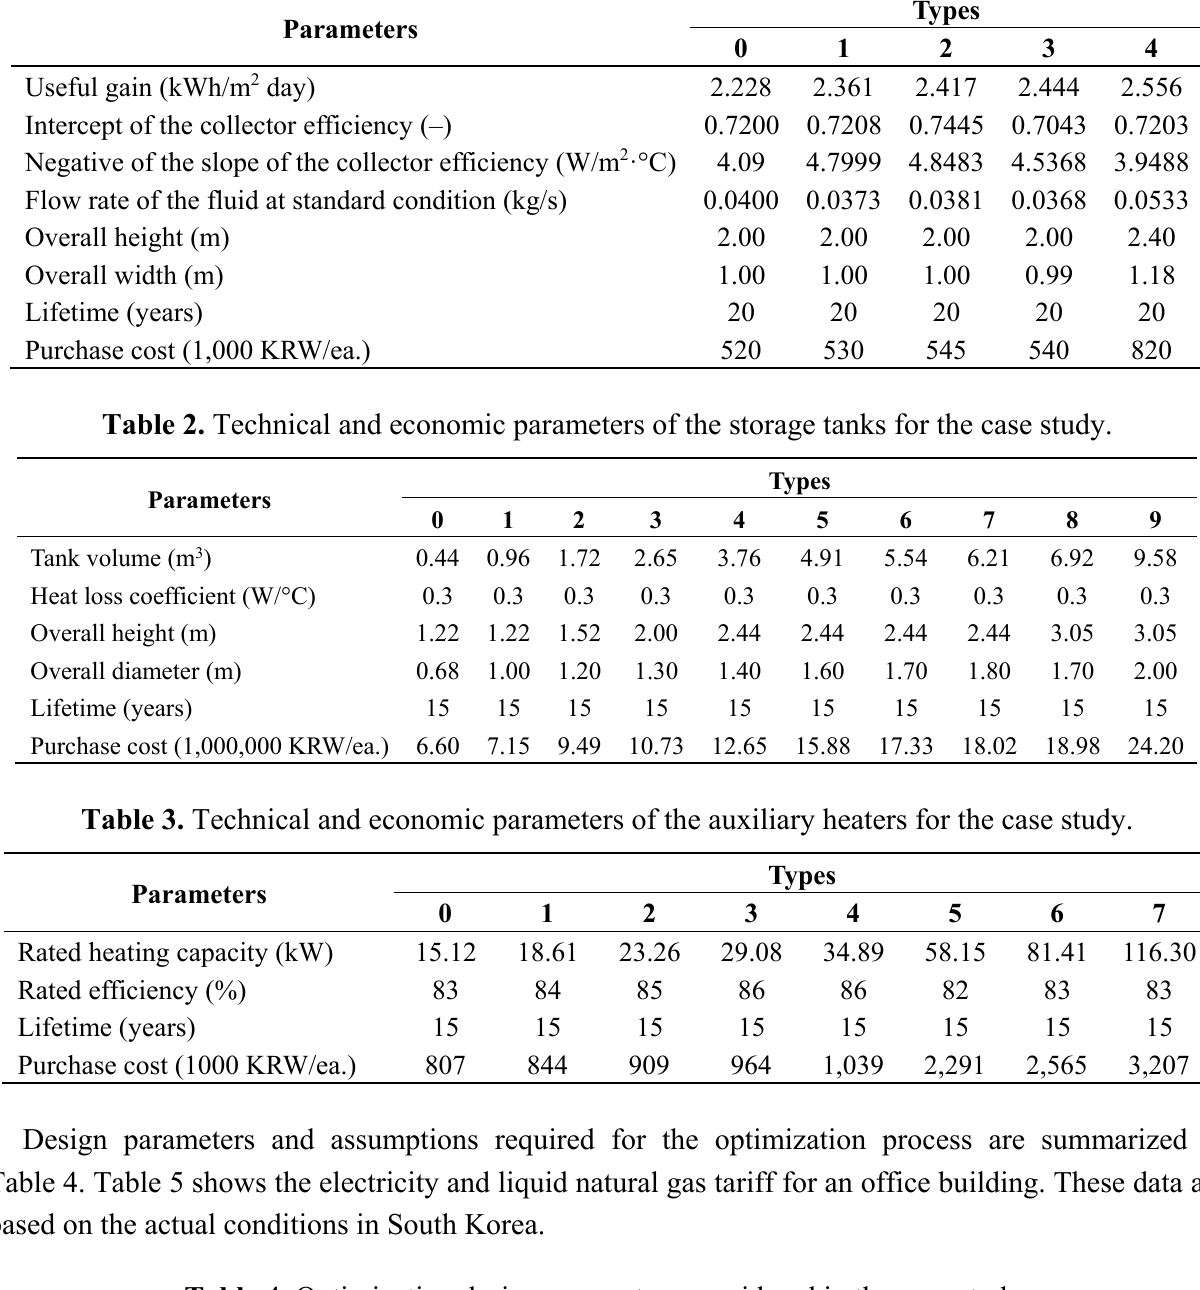
Table 4. Optimization design parameters considered in the case